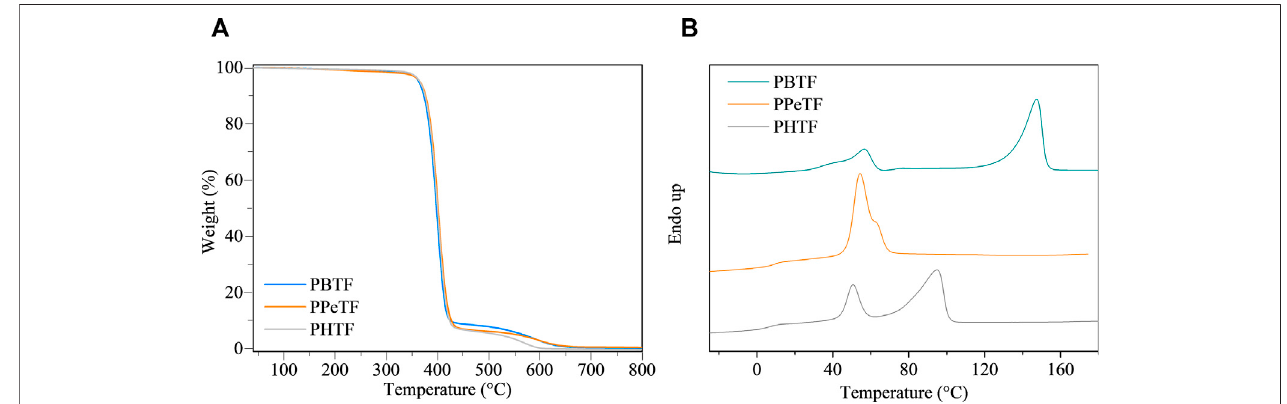
FIGURE 2 | (A) Thermogravimetric curves under nitrogen atmosphere (gas fl ow 30 ml/min and heating rate 10 ° C/min) and (B) fi rst DSC scan curves of the homopolymers under investigation.